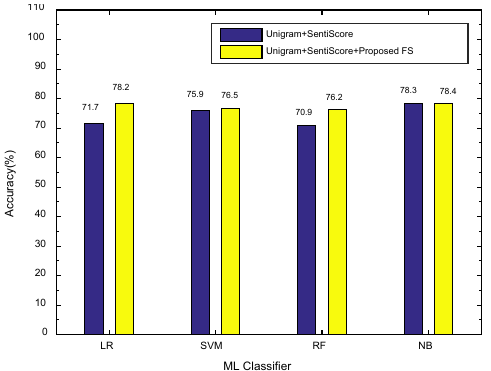
Figure 6. Accuracy Comparison of feature selection techniques on IMDB Movie Reviews